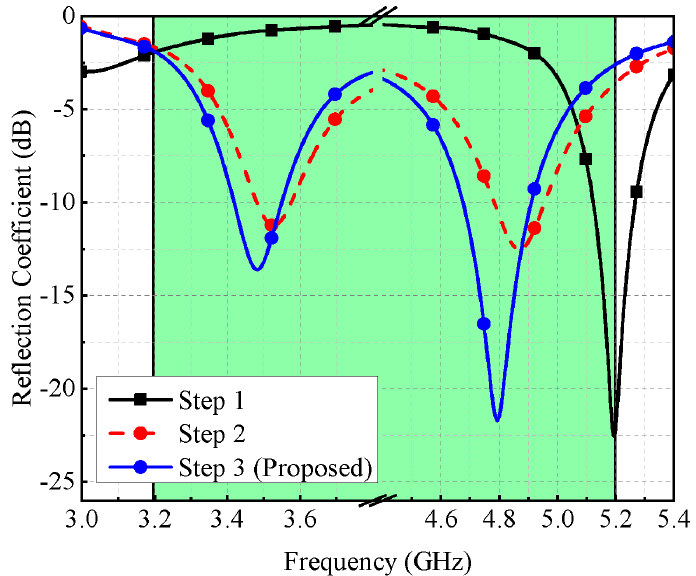
Figure 3. Reflection coefficient of different design stages.